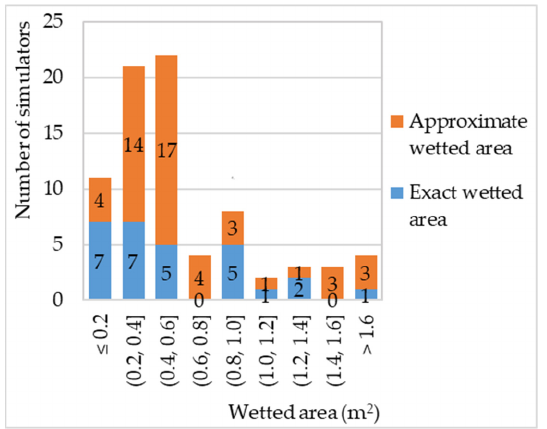
Figure 1. The number of DRS simulators with different wetted surface sizes.